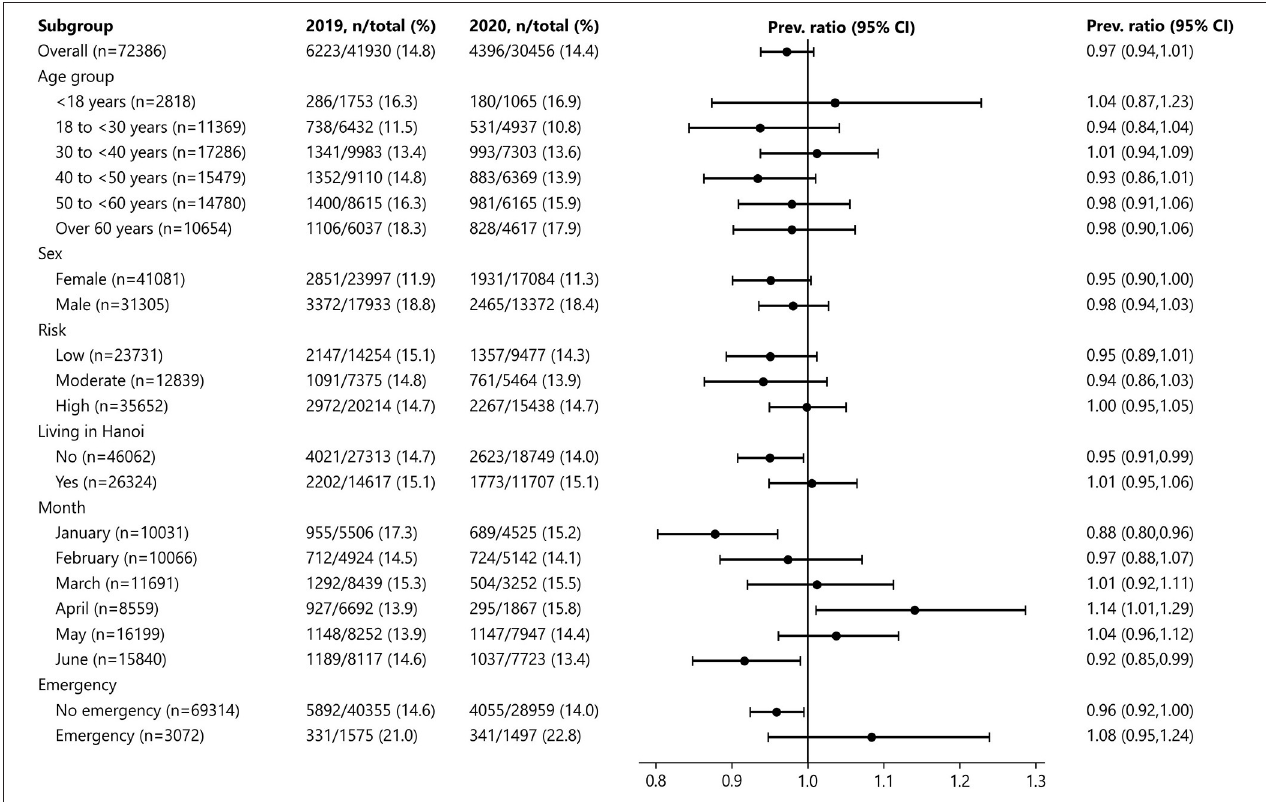
FIGURE 4 | Stratified comparison of the proportion of PUD between 2019 and